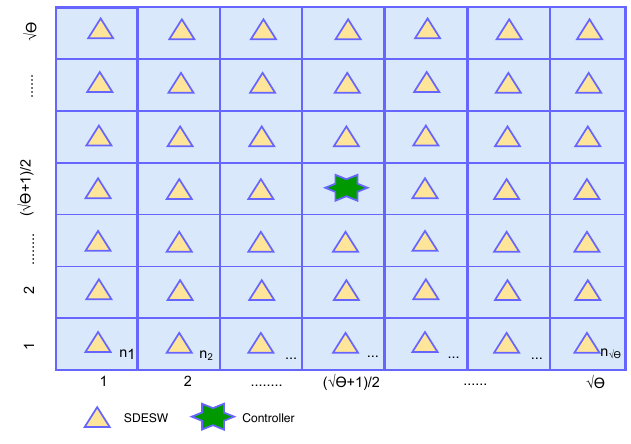
Figure 3. Hops in Building